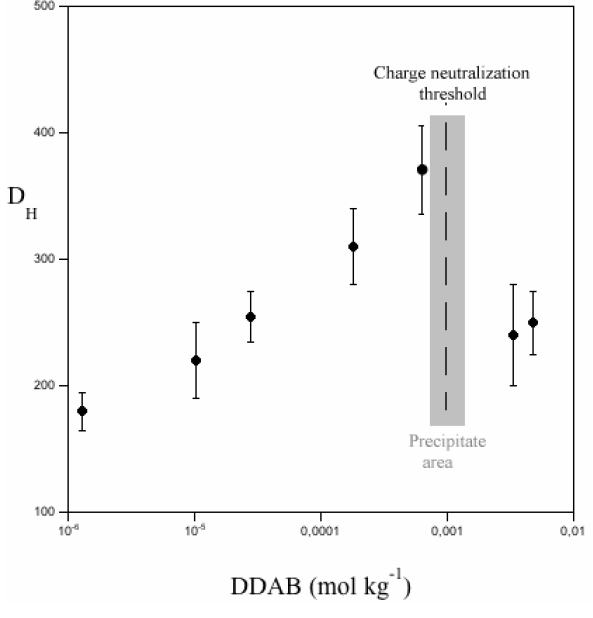
Figure 8. Average size of ss-DNA/CNT complexes, D H , in nm, versus the concentration of added DDAB, in mmol kg − 1 , at 25.0